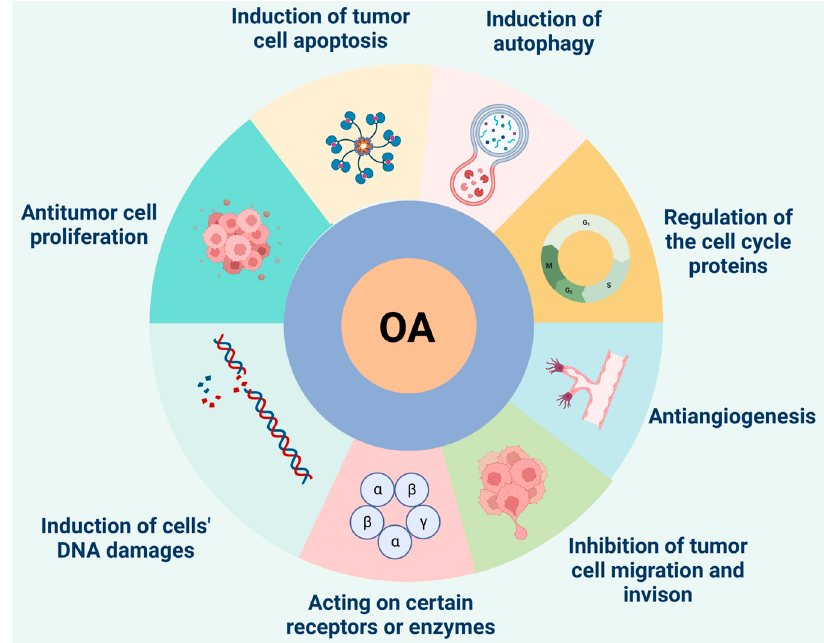
Figure 2. Anticancer ways of